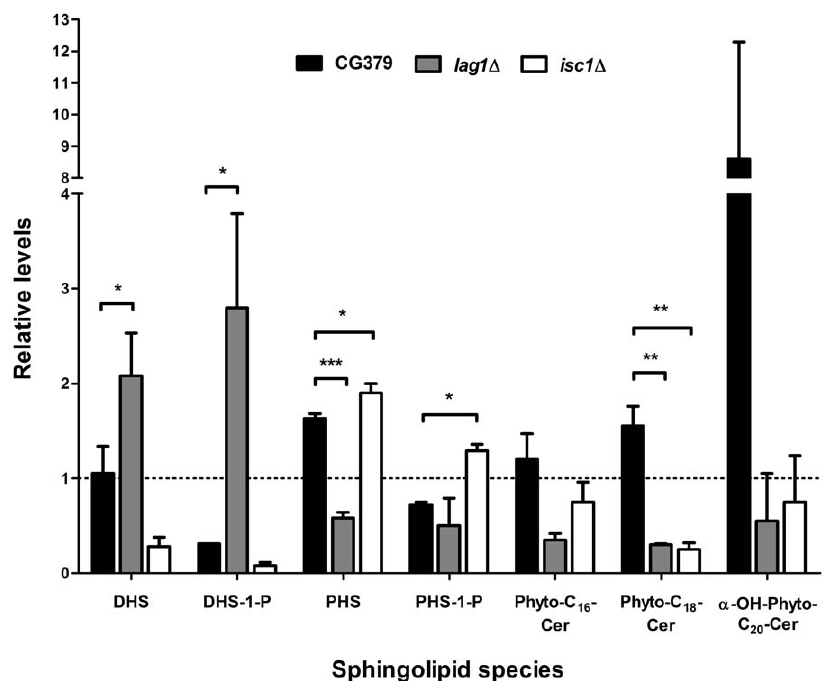
Figure 6. Changes in the levels of sphingolipid species during acetic acid-induced apoptosis. Relative levels of dihydrosphingosine (DHS), dihydrosphingosine-1-phosphate (DHS-1-P), phytosphingosine (PHS), phytosphingosine-1-phosphate (PHS-1-P), phytoceramides (Phyto-C 16 - Cer and Phyto-C 18 -Cer) and a -hydroxylated phytoceramide ( a -OH-Phyto-C 20 -Cer) in S. cerevisiae CG379 (wild-type), lag1 D and isc1 D strains after exposure to 180 mM acetic acid, pH 3.0, for 200 min are shown. Values are mean 6 SD of three independent experiments. * P , 0.05, ** P , 0.01, One- way ANOVA and Tukey Test. Levels of a -OH-Phyto-C 20 -Cer in CG379 reproducibly displayed a high increase after exposure to acetic acid in all experiments, though relative values varied